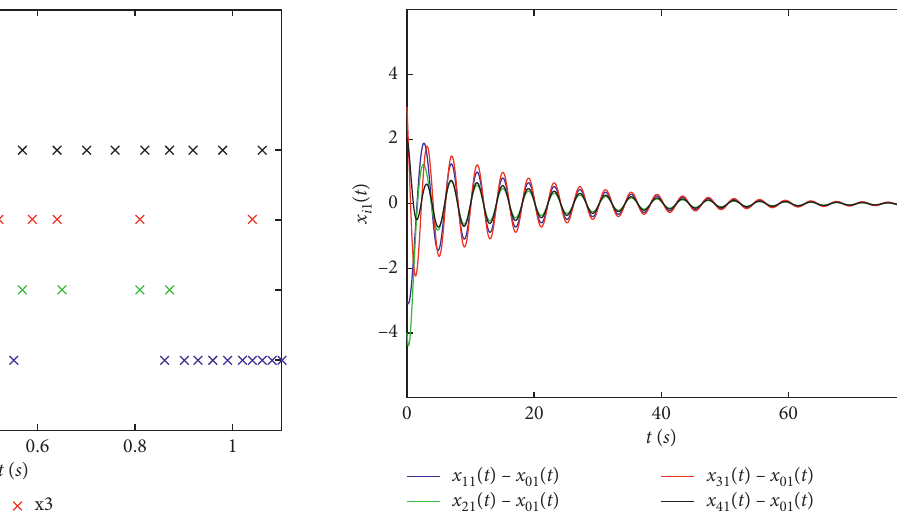
Figure 9: The 1st state error trajectory of each agent under protocol (48).